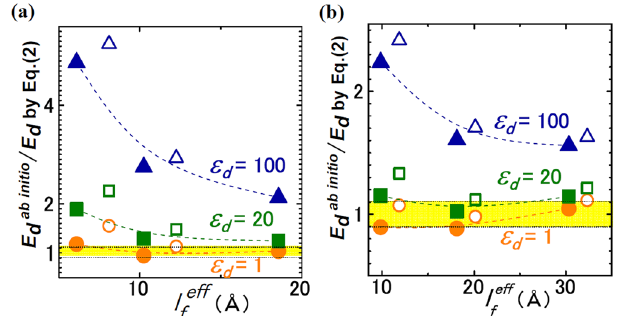
Figure 5. FE capacitor. Comparison of E dab initio with Eq. (2) with ε d = 1 (orange), 20 (green), and 100 (blue) for ( a ) BTO/SrRuO 3 and ( b ) BTO/Pt. The filled and open symbols represent the data for l feff = l T-B − uc BTO , l T-B − 1.5uc BTO ,